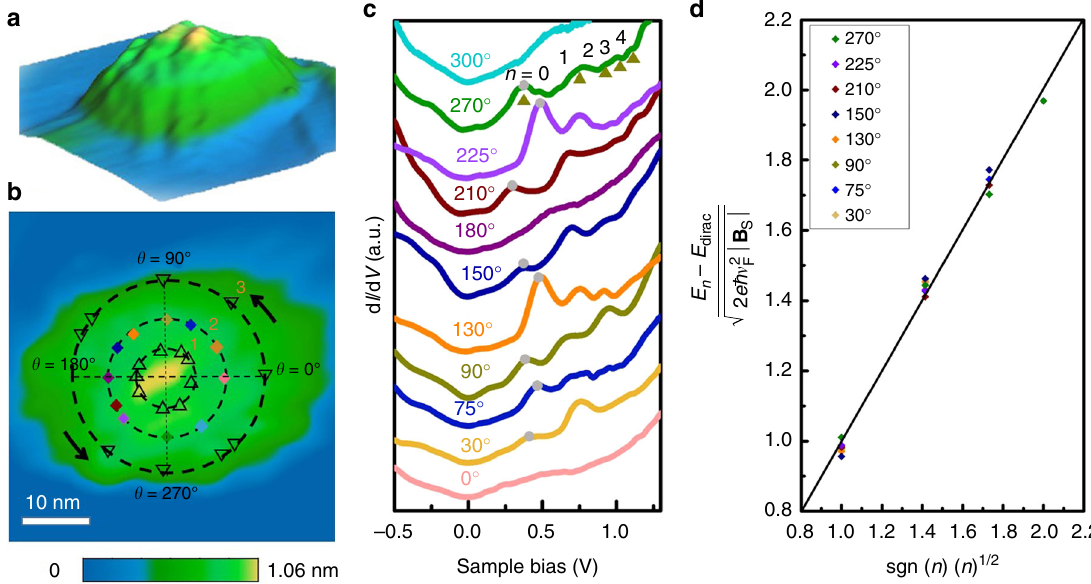
Fig. 3 STM and STS of the graphene bubble. a 3D STM image ( V b = − 750 mV, I s = 0.22 nA) of a typical GNB on Ge(110) with the radius of ~13.5 nm and maximum height of ~1 nm. b 2D projection of the GNB shown in a . c d I/ d V spectra recorded on the colored diamonds at different rotational angles (or second circle line) in b . The gray dots indicate the sites of Dirac points. d Normalized peak energies ð E